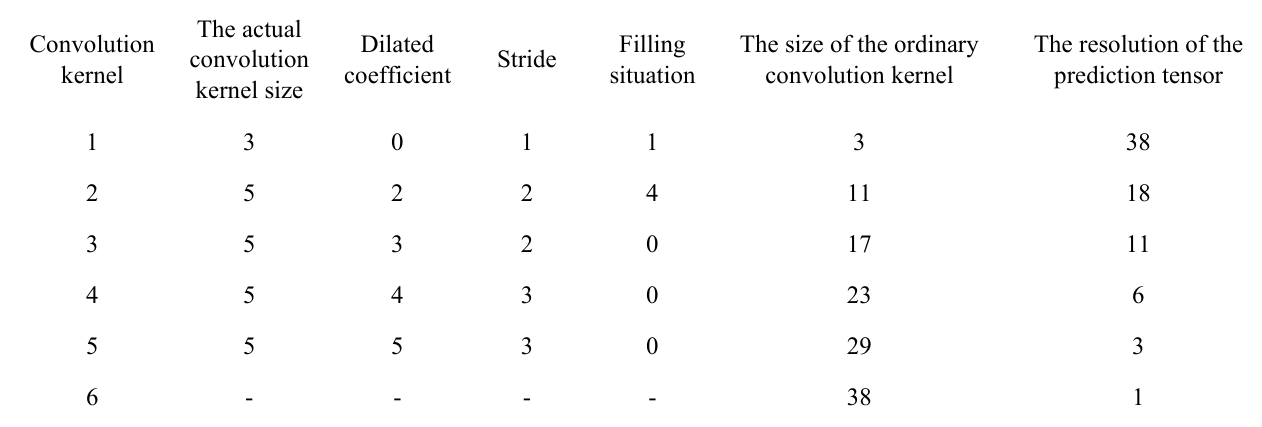
Table 1. Designed dilated convolution filter